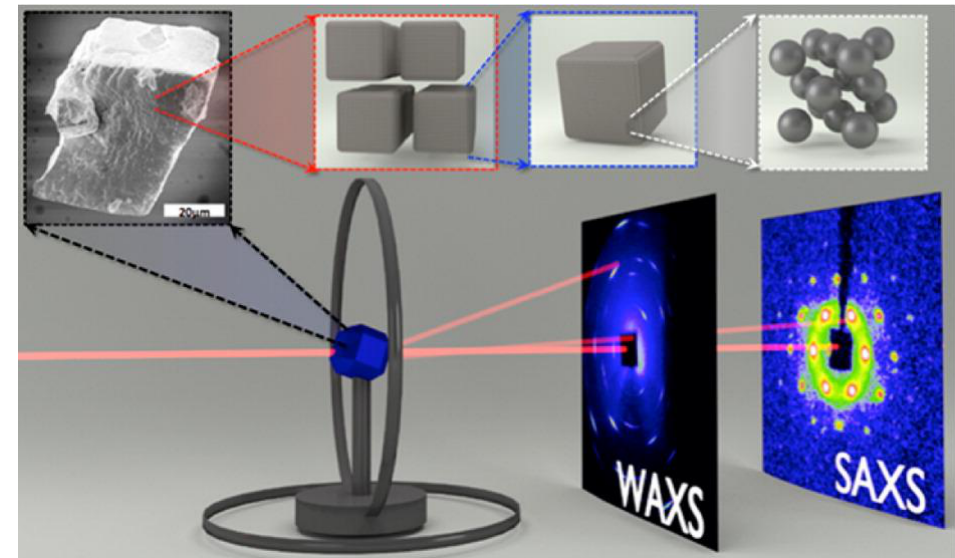
Figure 1. Schematics of experimental setup for the collection of both SAXS and WAXS images from the same orientations of supercrystal upon rotation of a supercrystal grain mounted on a portable two circle diffractometer. The top panel shows the full-length scales of the assembled supercrystal from atomic through nano and meso to bulk. Copyright of the American Chemical Society [38].